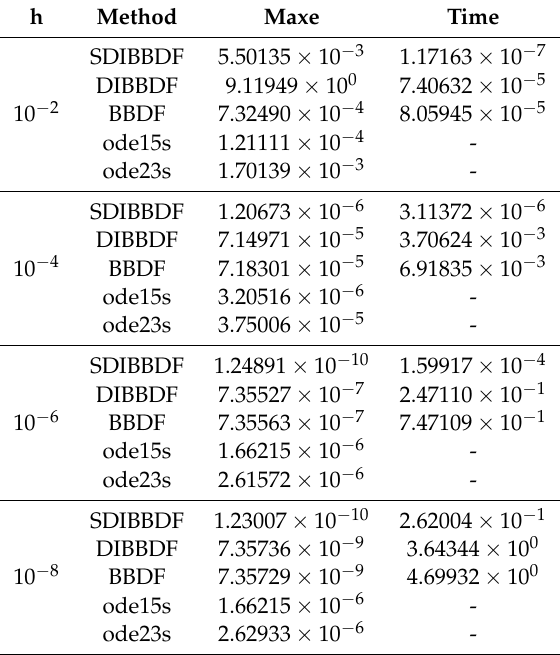
Table 3. Numerical results for test problem 2.